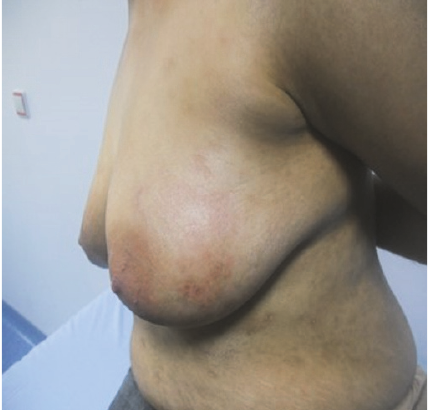
Figure 3: After treatment with 0,05% clobetasol propionate cream. Note the complete